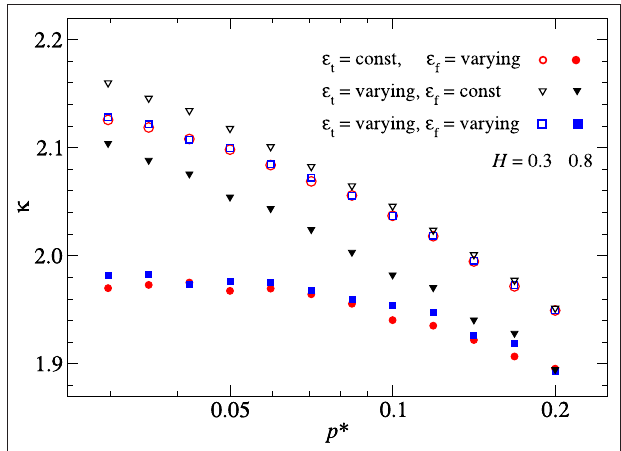
FIGURE 4 | Proportionality coefficient κ as defined in Equation (27) for two Hurst exponents and three different choices of how ε f,t change with pressure p . The term “const” relates to ε t 1 / 2 and ε f 1 / 32. These two values are the = = reference values at p ∗ 0.2. The term “varying” indicates that the respective ε = is scaled according to Equation (27). To give an example, the scaling makes a varying ε f go down to 1/64 and a varying ε t to 1.4 at p ∗ 0.0125. Results = were averaged over up to 100 random realizations per data point.